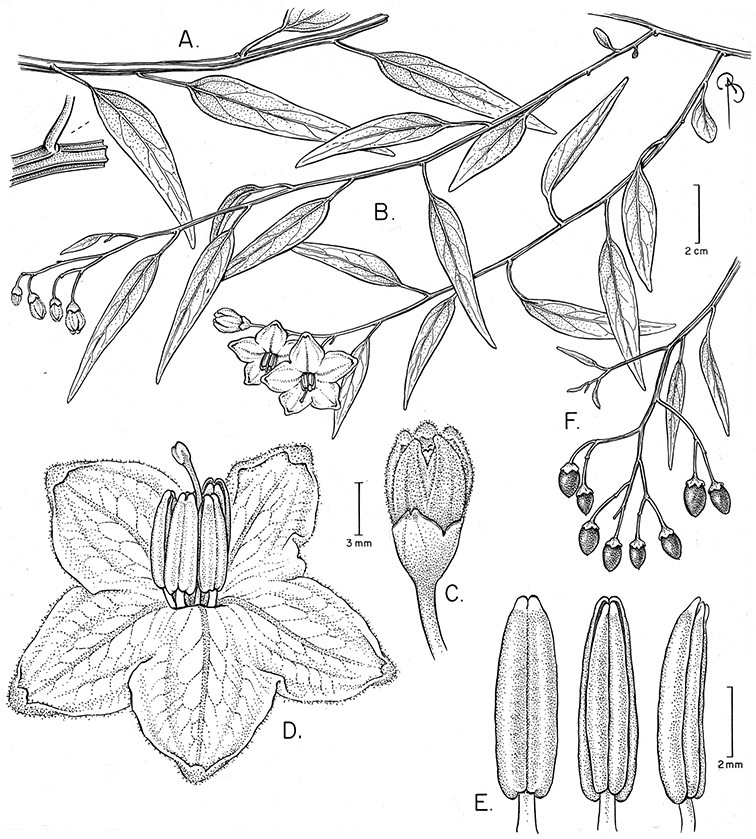
Solanum amygdalifolium Steud. (A, C–E drawn from Nee 52046
B drawn from Mendoza 102). Illustration by Bobbi Angell.